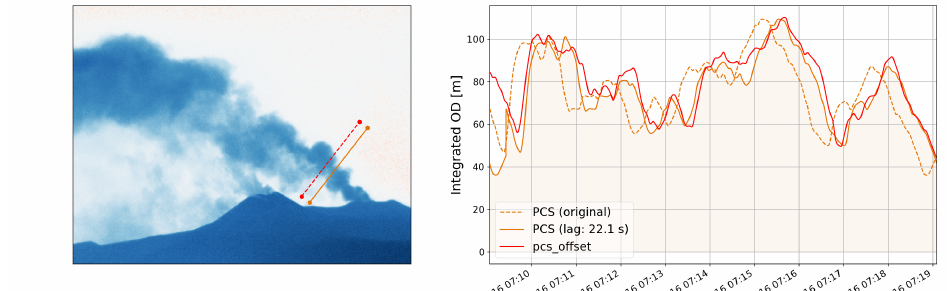
Figure 8. Plume velocity retrieval using the cross-correlation method applied to a time-series of on-band OD ( τ On ) images. Left: example plume image including the two used PCS lines. Right: Time-series of the integrated optical densities along both lines (orange dashed and cyan line) in addition to the PCS signal shifted using the retrieved correlation lag of 22.1s (orange profile). The analysis yields an average gas velocity of